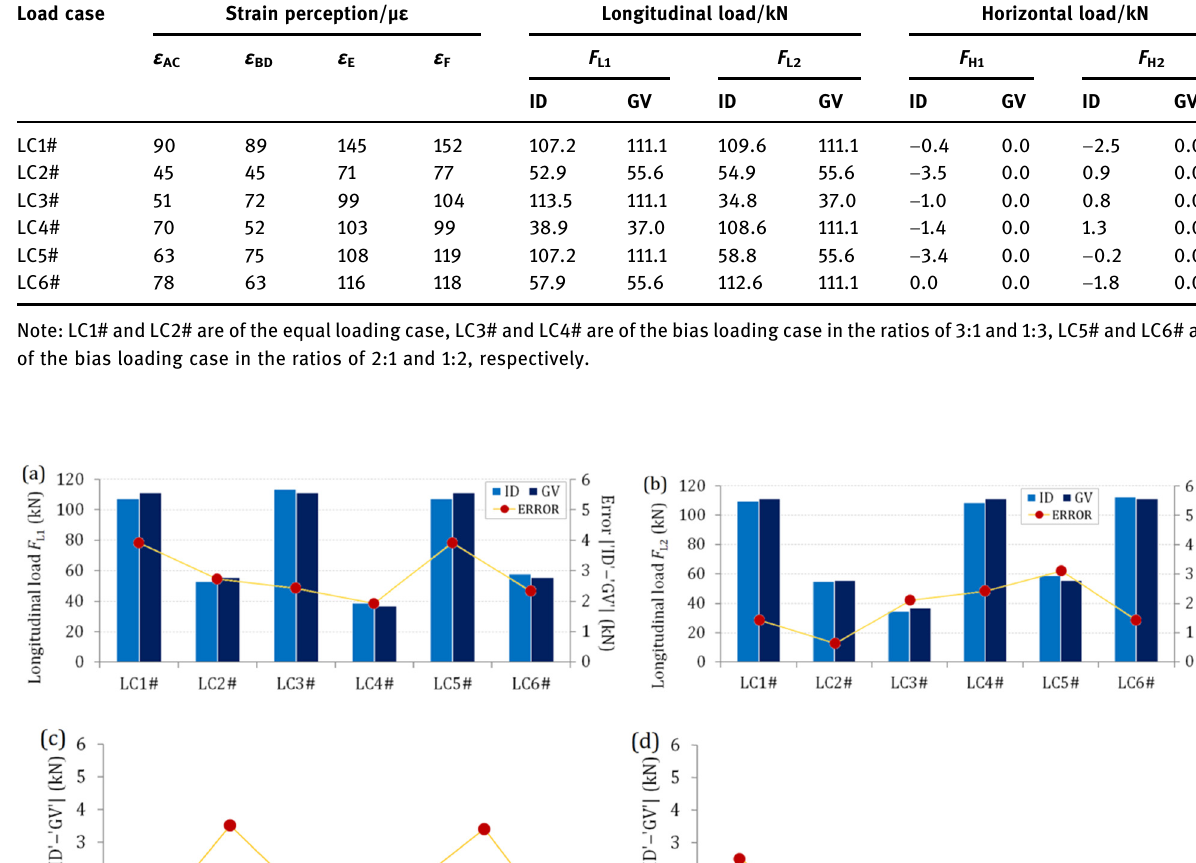
Table 4: Comparison between identi fi ed and given loads in loading experiment Load case Strain perception/µ